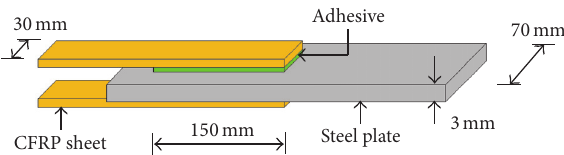
Figure 1: CFRP composite double strap joint